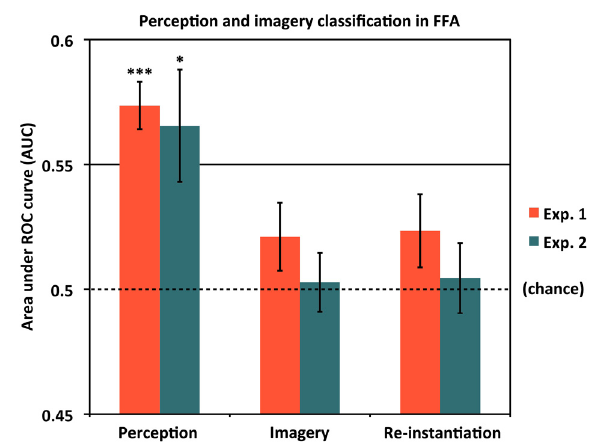
FIGURE 6 | Classifying scene identity information in face-selective cortex. Classification accuracy for Experiments 1 and 2 using voxels from the fusiform face area (FFA). Results are shown for classifying between different scene items during perception (left bars), classifying between scene items during mental imagery (middle bars), and re-instantiation of perceptual information during mental imagery (right bars). Accuracies were significantly above chance (AUC = 0.5) during perception for both experiments, but did not differ from chance in either experiment during imagery or for re-instantiation. Analyses used 80 voxels from each of the left and right FFA, for a total of 160 voxels. ∗ p < 0 . 05, ∗∗∗ p < 0 . 001. Error bars represent s.e.m. See text and Table 1 for full